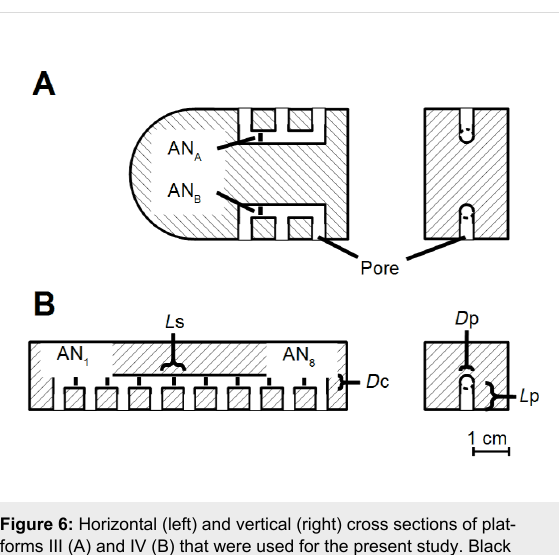
Figure 6: Horizontal (left) and vertical (right) cross sections of plat- forms III (A) and IV (B) that were used for the present study. Black squares indicate the positions of the ANs inside artificial lateral line canals. Platform III housed two and platform IV housed eight ANs. The length of pores ( L p) was 1 cm, the inter pore distance ( L s) was 1 cm and the diameter of the canal ( D c) as well as the pore diameter ( D p) was 3 mm in both